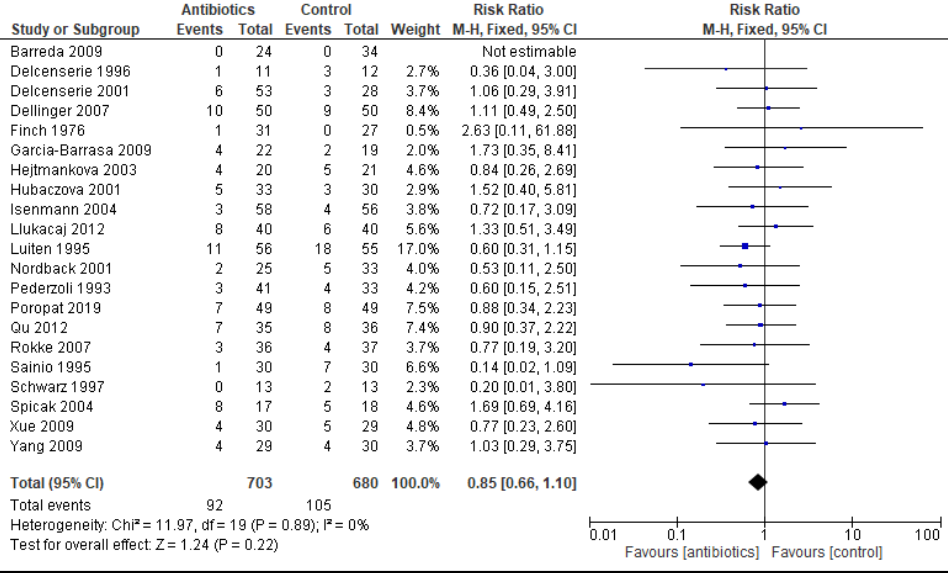
Figure 3. Forest plot of comparison of antibiotics versus control; outcome: mortality. Data from 21 trials showed 92 deaths occurring in the PAB group (N = 703) compared to the 105 deaths in the control group (N = 680). A RR of 0.85 (95% CI 0.66 to 1.10) and a heterogeneity of 0% confirmed no significant difference in mortality rates.